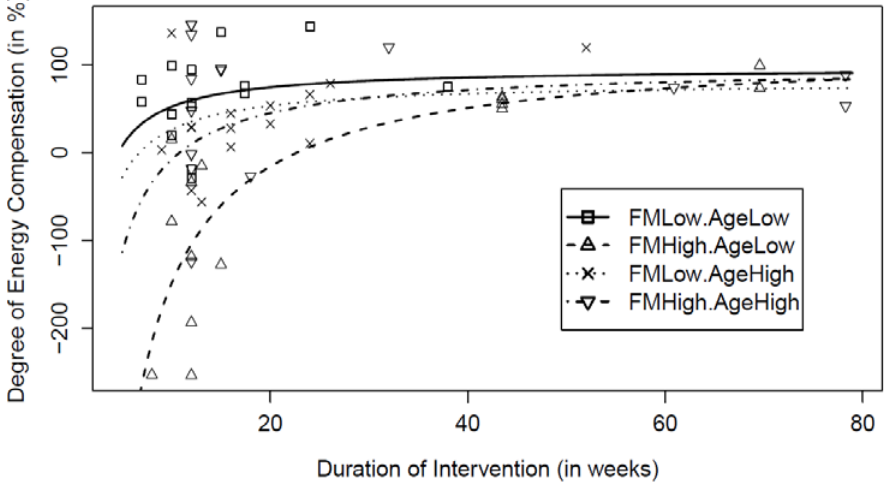
Figure 3. Degree of energy compensation illustrated as the interaction between age and initial FM of individuals, as well as with the duration of each exercise intervention. Each exercise intervention study is represented by a